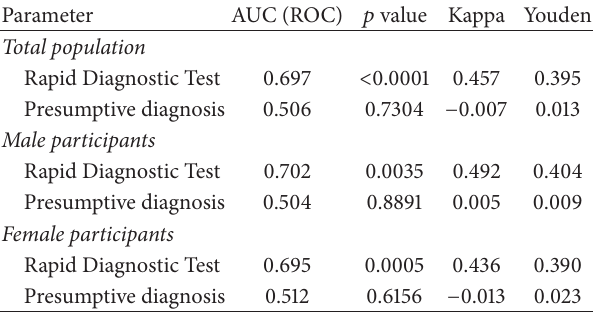
Table 3: Interrater diagnostic performance criteria for rapid and presumptive diagnosis of malaria with field microscopy as a gold standard.